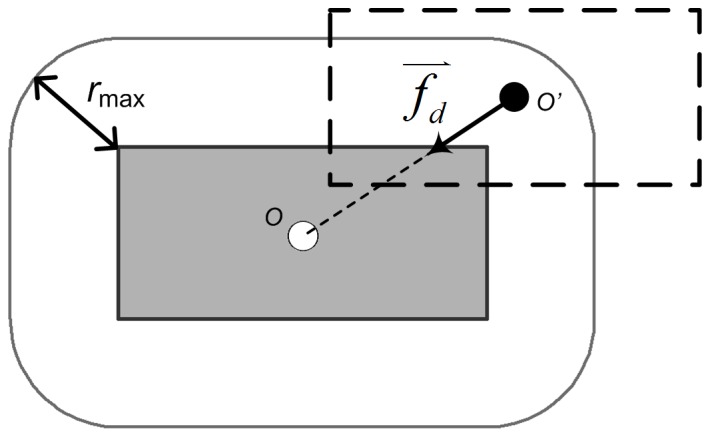
Positional accuracy constraint and drag force.
O is the original position of the building’s centroid, O′ is the new position of the building’s centroid after displacement, and r
max is the threshold of positional accuracy. If , a drag force, , will be introduced to drag the building back to the acceptable area again.